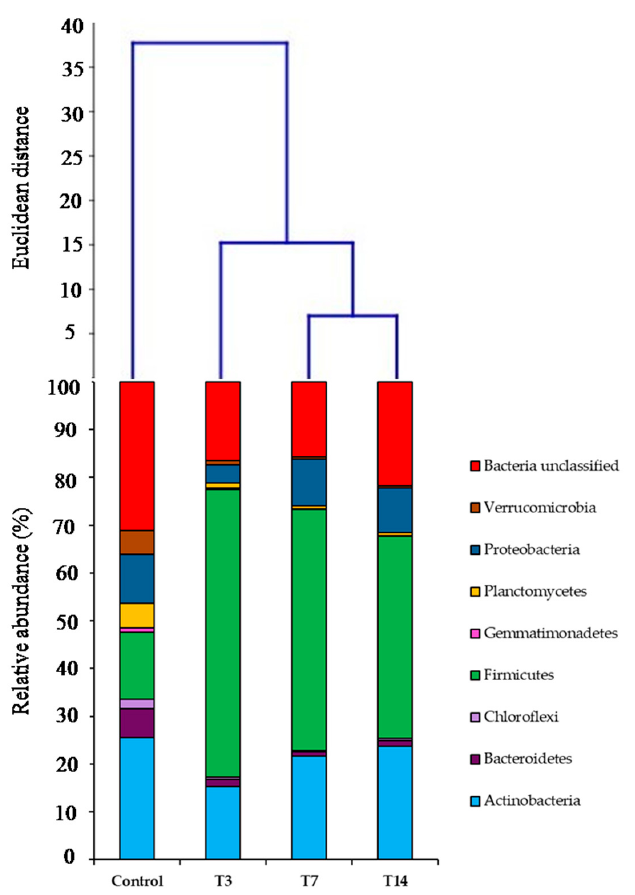
Figure 3. Relative abundances of the dominant bacterial phyla (>1%) and cluster analysis of control, T3, T7 and T14 samples using Ward’s method.